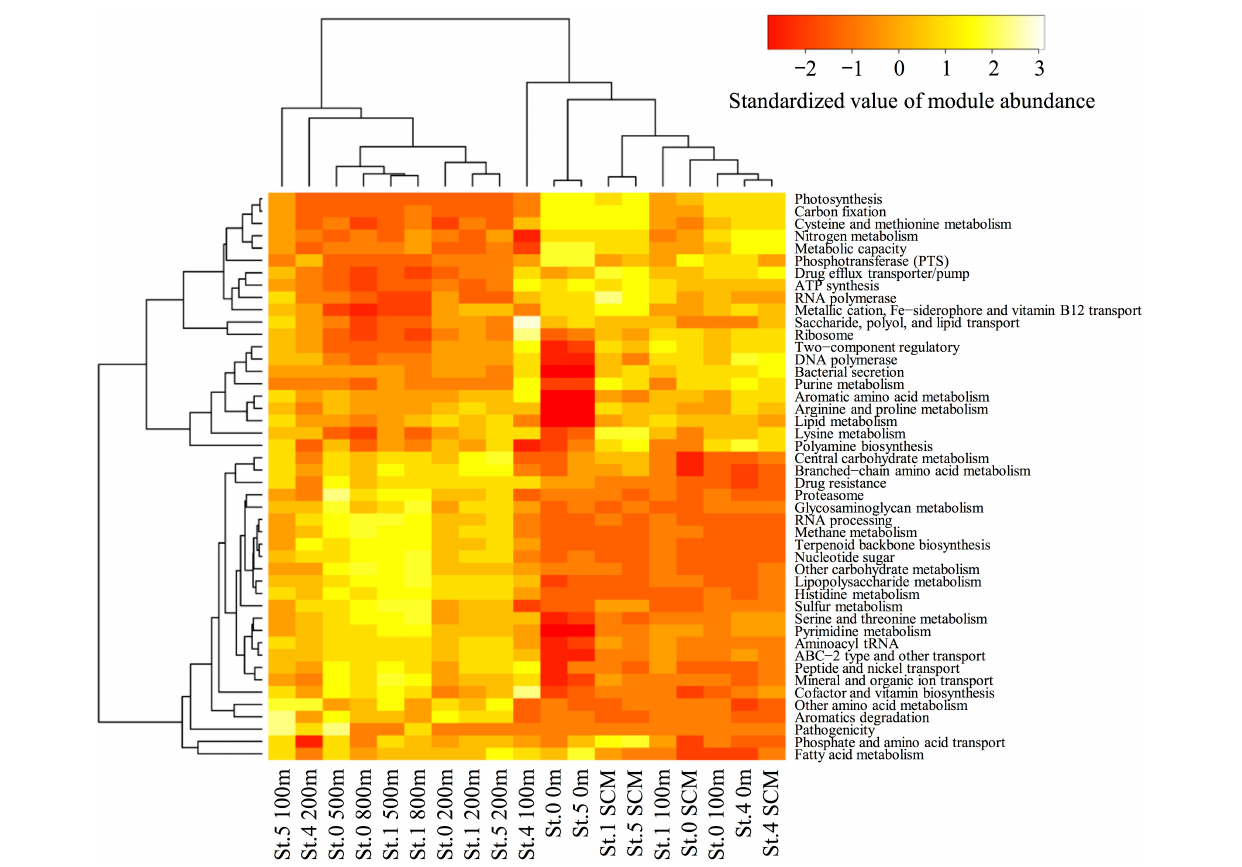
FIGURE 6 | Heatmap of the relative functional module abundances determined using the MAPLE analysis with the paired-end reads from the metagenomic data. The values of module abundance are standardized with average and standard deviations. The module abundance was normalized with reference to ribosomal protein